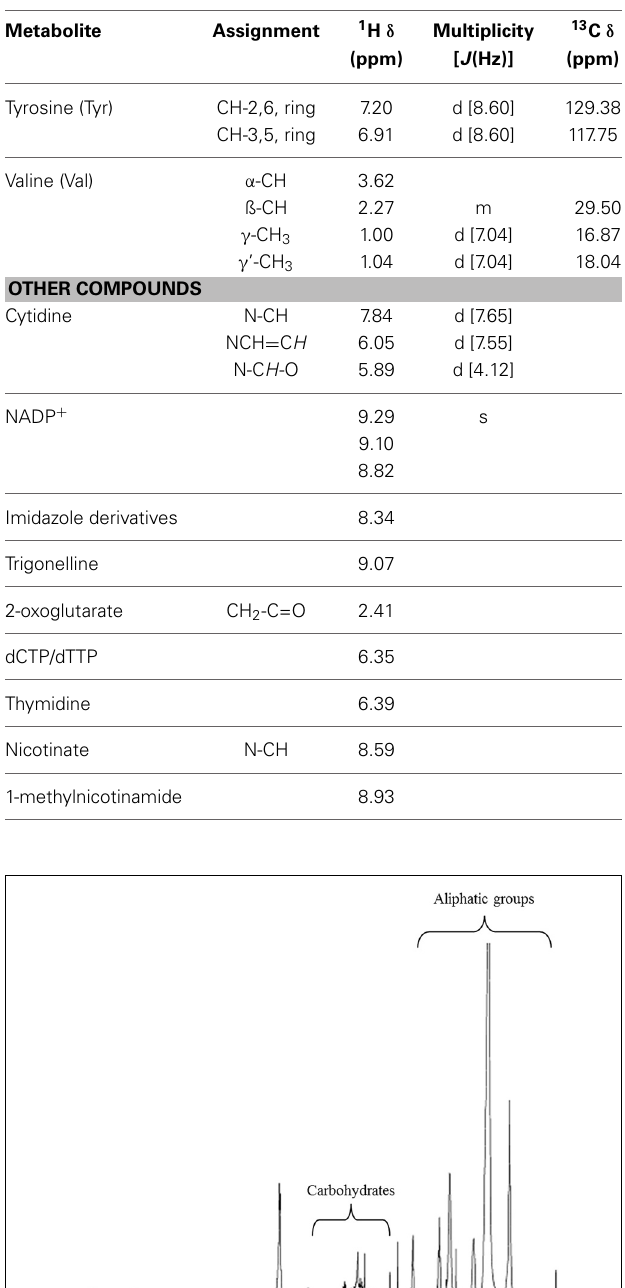
development and fruit quality. The beneficial effects